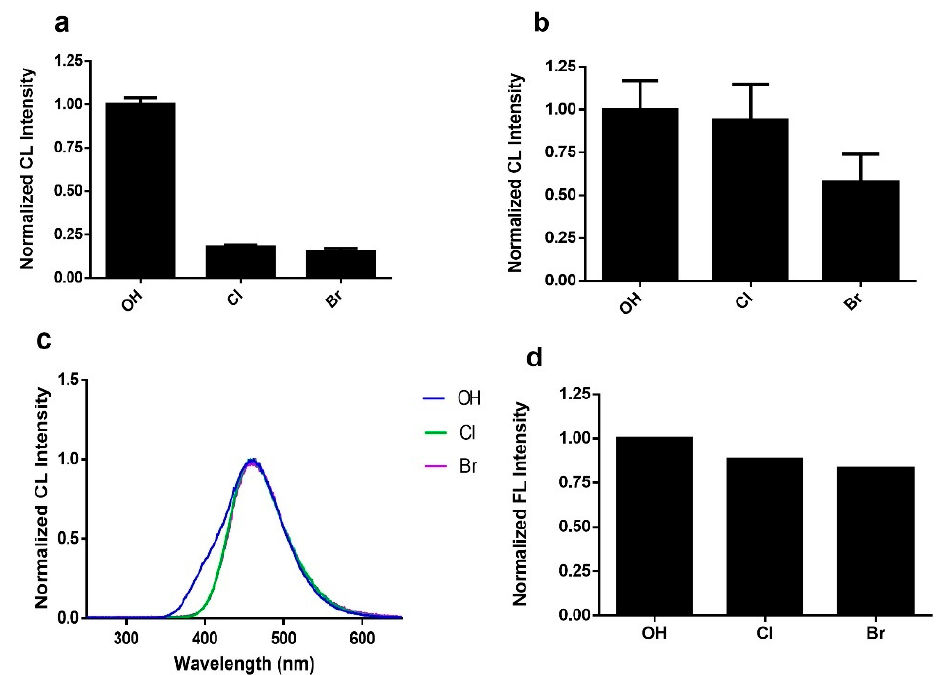
Figure 2. ( a ) Normalized chemiluminescence output of OH-, Cl-, and Br-Cla in DMF-acetate buffer pH 5.14 (0.68%). ( b ) Chemiluminescence intensity of OH-, Cl-, and Br-Cla in the presence of 20 mg of KO 2 in methanol. ( c ) Normalized chemiluminescence spectra of OH-, Cl-, and Br-Cla in DMF-acetate buffer pH 5.14 (0.68%). ( d ) Normalized fluorescence intensity of spent chemiluminescent reactions of OH-, Cl-, and Br-Cla coelenteramide after 30 min of reaction.